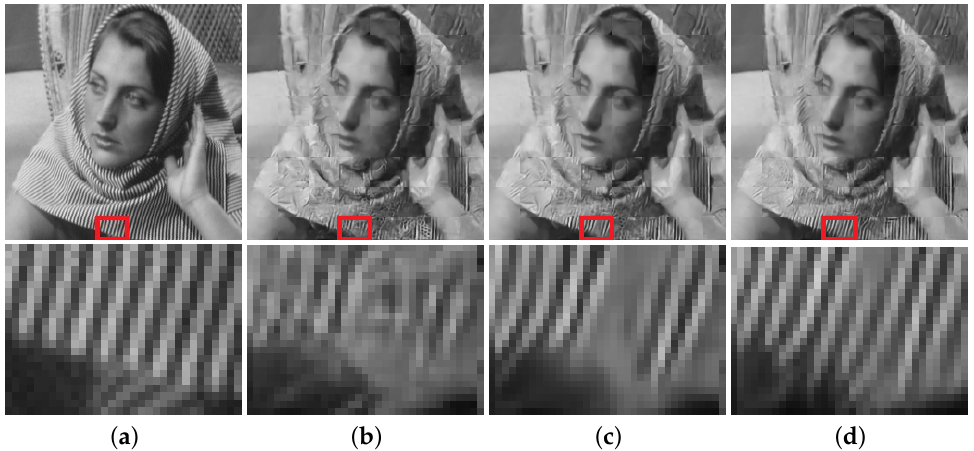
Figure 7. Reconstruction of the Barbara image with a CS ratio of 10% using the 9-phase ISTA-Net + (PSNR 23.59dB), 9-phase EPGN (23.89dB), and 7-phase NL-EPGN (24.27dB). ( a ) Ture. ( b ) ISTA-Net + . ( c ) EPGN. ( d )